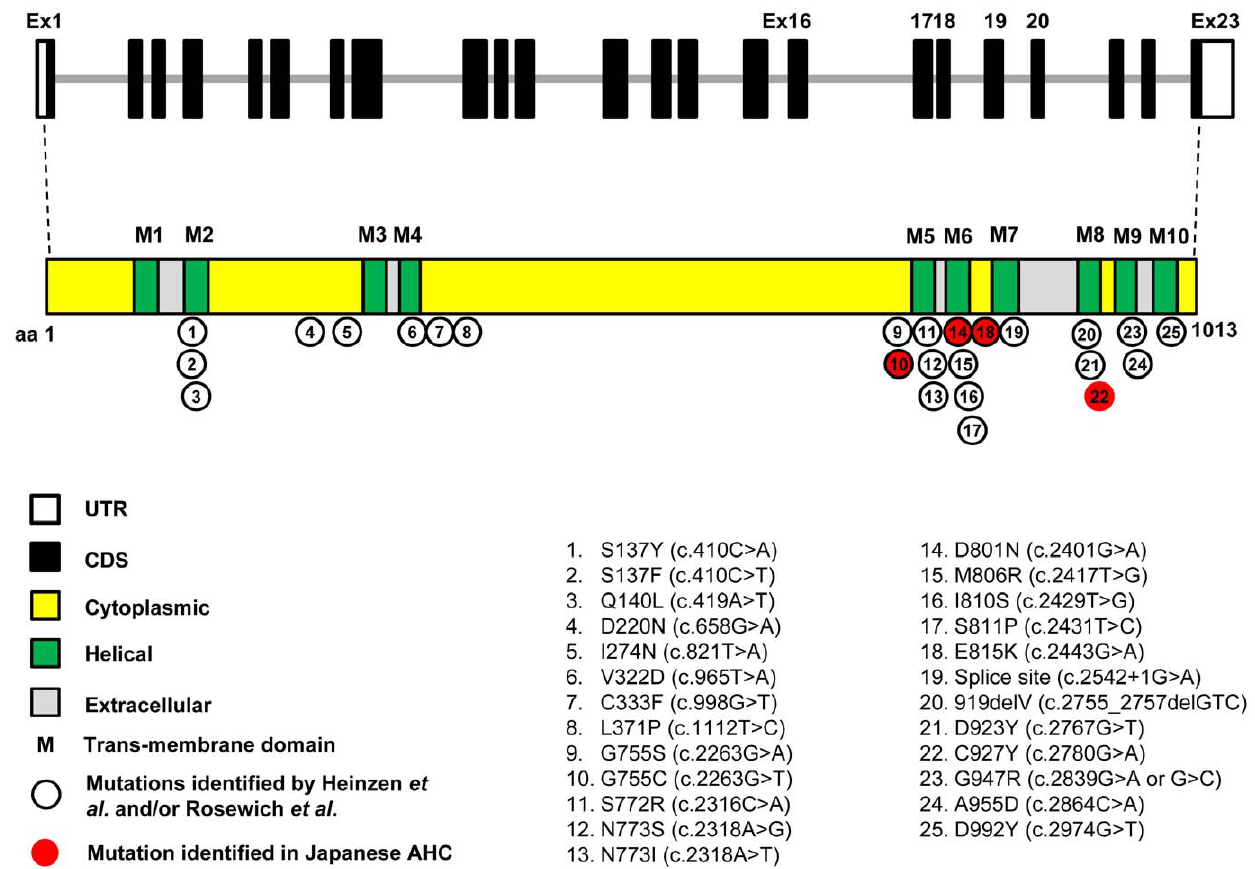
Figure 3. ATP1A3 mutations and their protein domain structures. Black lined circle: Mutations reported recently [10,11]. Red colored circle: Mutations identified in the present study in a Japanese cohort with AHC. The ATP1A3 gene consists of 23 exons that encode several domains in the ATP1A3 protein molecule, including 6 cytoplasmic, 10 helical and 5 extracellular domains. G755C and E815K were located in the cytoplasmic domains. Notably, E815K was resident of the transmembrane domain rather than the cytoplasmic domain. D801N and C927Y were located in the helical domains. C927Y was identified in this study only and hence considered novel.